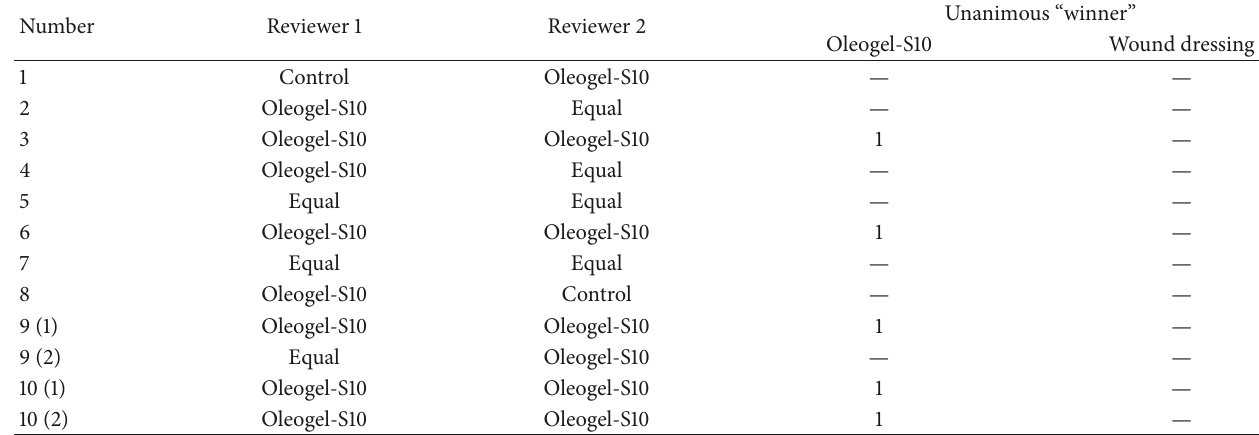
Table 3: Results of blinded efficacy evaluation by patient and